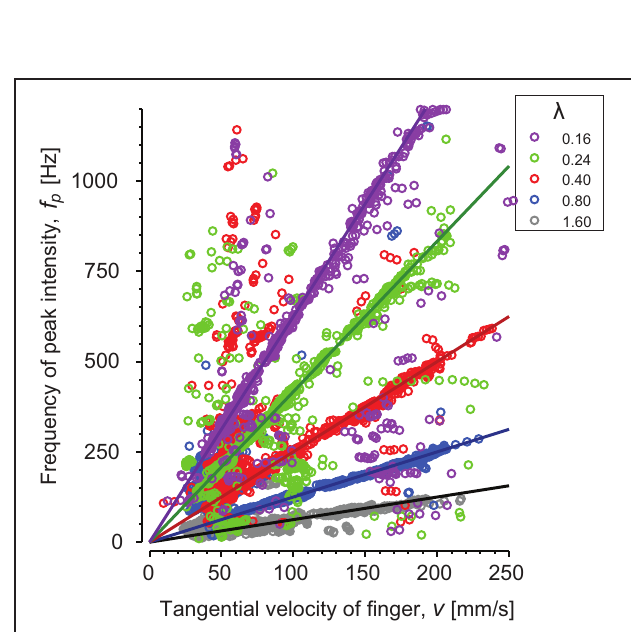
FIGURE 4 | Individual trial (A) on a periodic grating of spatial period λ = 0 . 8mm and (B) on a sandpaper P240: evolution of normal force NF, tangential force TF, velocity of the finger v and spectrum of the sound over time. t slip corresponds to the onset of the slip.